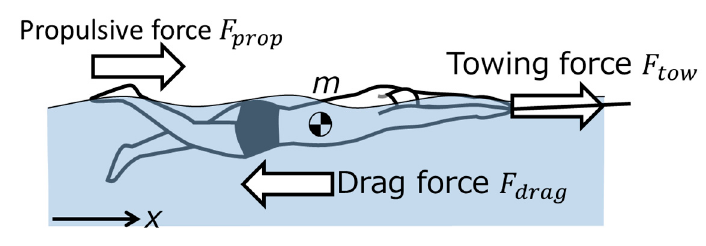
Figure 3. Mathematical model of towing swimming with only the kick